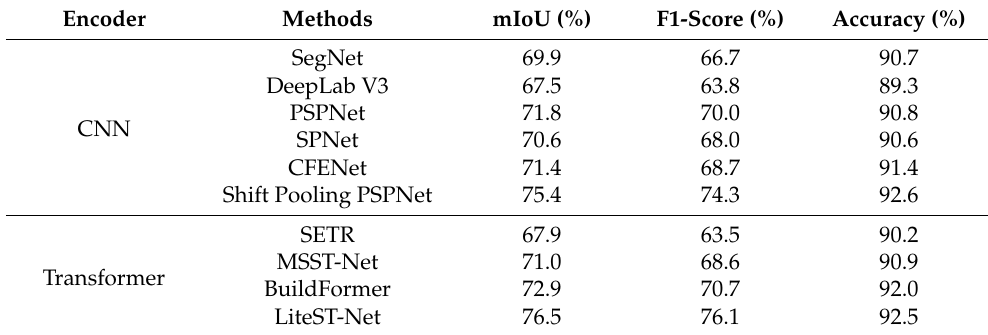
Table 2. Results of classic semantic segmentation on the Massachusetts building test dataset.